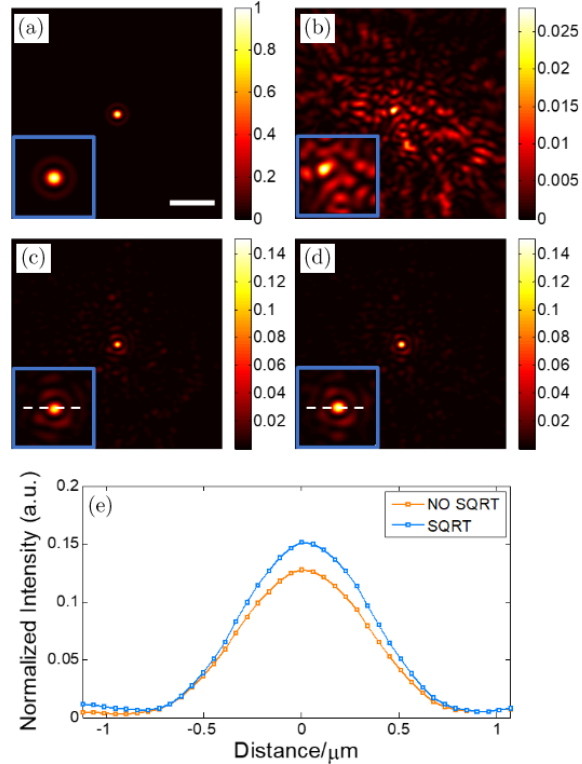
Fig. 4. (a) The ideal focal spot formed without the scattering medium (scale bar: 5 (cid:1) m). (b) The focal spot scattered by the medium. (c) The recovered focal spot using the conventional method. (d) The recovered focal spot using our method. (e) The intensity pro¯les along the white dashed lines shown in (c) and (d).